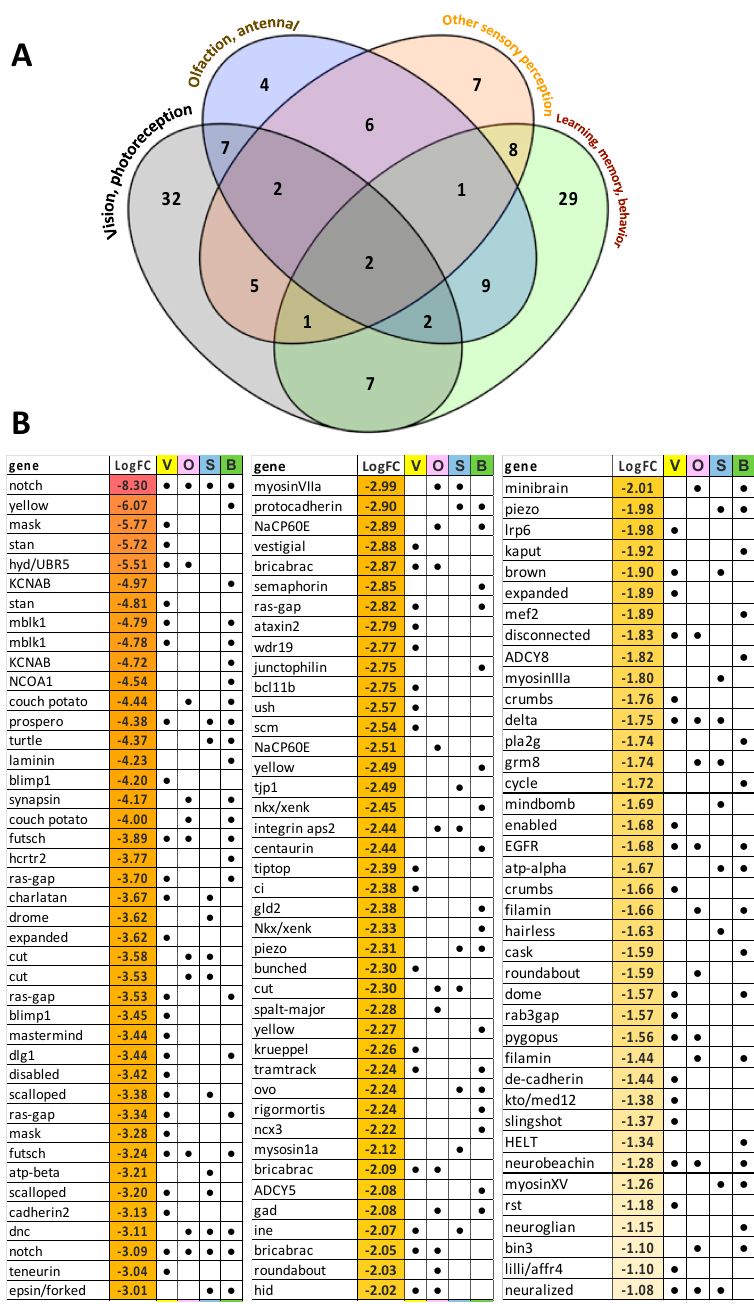
Figure 5. Unigenes associated with sensory processes, behavior, learning and memory that were significantly downregulated in EHDV-2 infected midges. Differentially-expressed unigenes were manually inspected, catalogued and categorized to present sets associated with sensory processes (vision, olfaction, other) and brain functions (learning, memory, behaviors). ( A ) 122 unigenes were downregulated with EHDV-2 infection: 62 associated with vision, 35 associated with olfaction, 32 other sensory functions (e.g., gustatory, touch), 59 brain functions. ( B ) Log 2 FC in expression of unigenes associated with vision (V), olfaction (O), other sensory (S) and brain functions (B) are given. As both panels indicate, many of these unigenes have overlapping functions. Further details including functional roles for each unigene can be found in Supplementary Table